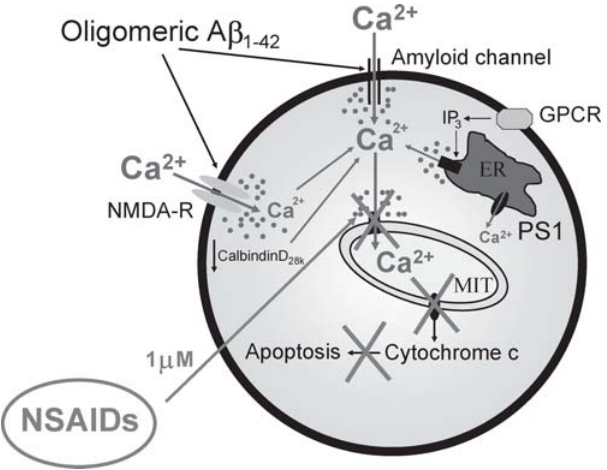
Figure 9. A model of A b -induced toxicity and neuroprotection by NSAIDs based on mitochondrial Ca 2 + . A b 1–42 oligomers and the toxic fragment A b 25–35 induce a large entry of Ca 2 + through the plasma membrane likely mediated by formation of amyloid channels and/or NMDA receptors. This entry promotes in a sequential manner mitochondrial Ca 2 + overload, ROS production, mPTP opening, cyto- chrome c release, apoptosis and cell death. Other factors related to AD may favor mitochondrial Ca 2 + overload including exaggerated IP 3 - induced release of Ca 2 + from the ER in loss of function PS1 mutants related to familial AD and/or decreased abundance of endogenous Ca 2 + buffers as calbindinD28k during aging or sporadic AD. NSAIDs, at low concentrations (1 m M), depolarize partially mitochondria and inhibit mitochondrial Ca 2 + overload, thus preventing cytochrome c release and apoptosis induced by A b